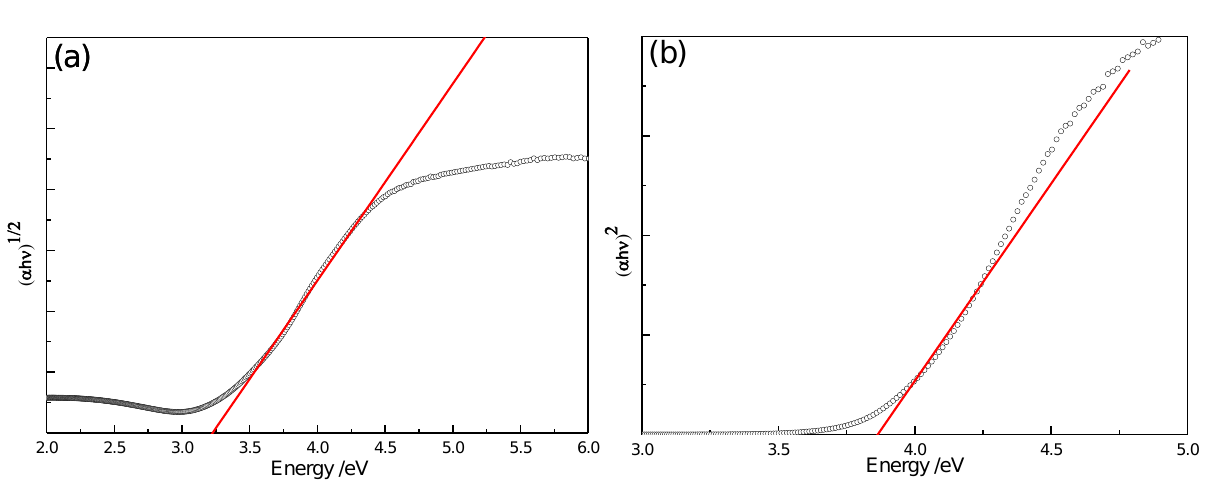
Figure 5. Plot of ( αhν ) 1/m vs . ( hν ) for the estimation of the band gap energy value (400 °C annealed TiO coating): ( a ) indirect gap and ( b ) direct gap. 2